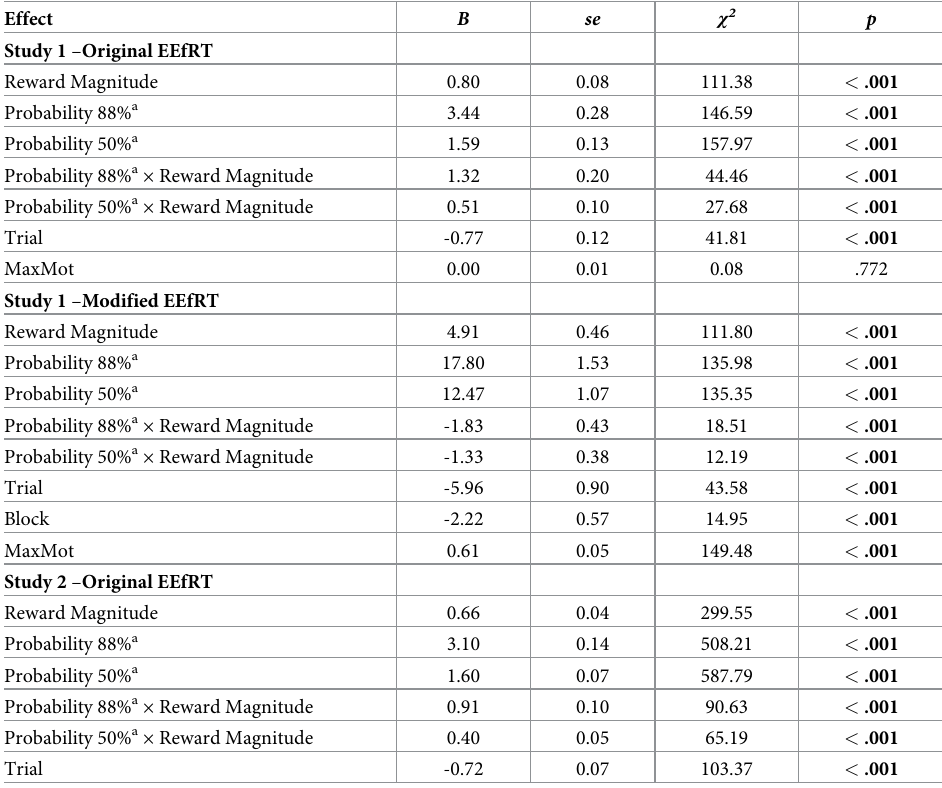
Note . All models included probability (categorical), reward magnitude, and trial number (divided by the individual maximum number of trials) as within-subjects variables; 2 = Wald chi-square; = regression coefficient; significant effects in bold. a Reference category: 12%